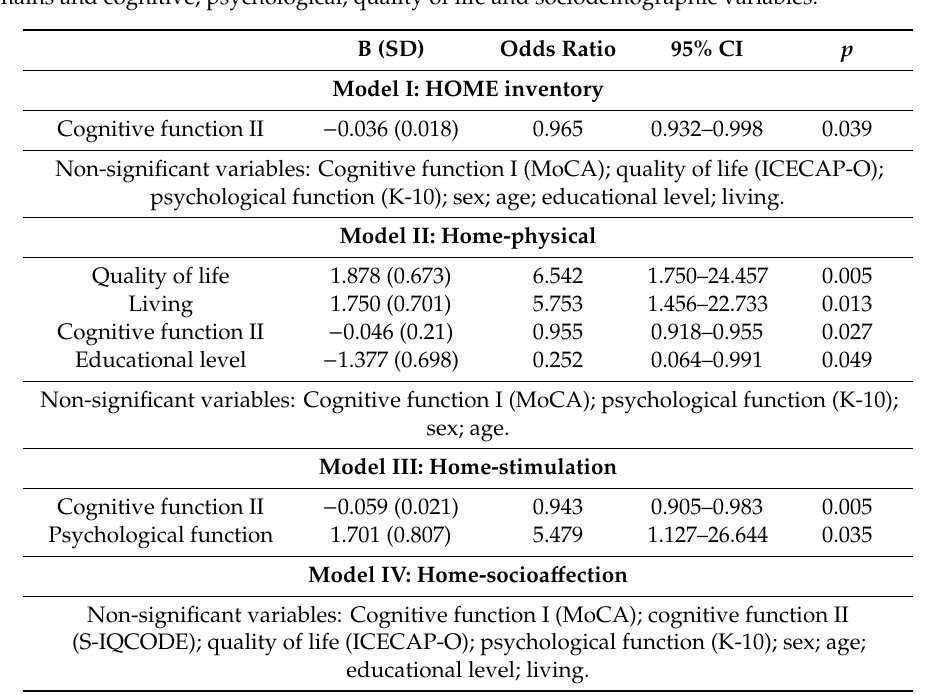
Table 2. Summary of the multivariate binary logistic regression models between adequate HOME domains and cognitive, psychological, quality of life and sociodemographic